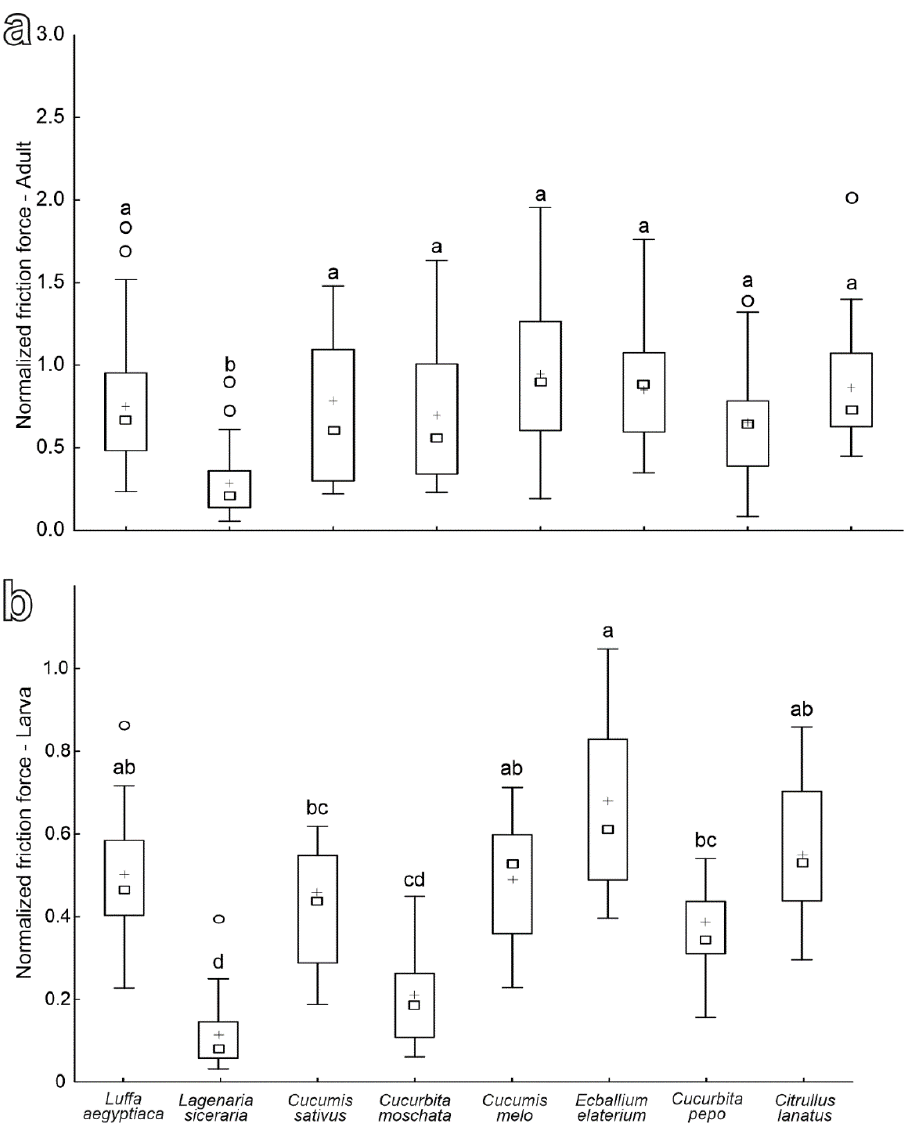
Figure 8. Normalized friction force of females ( a ) and larvae ( b ) of Chnootriba elaterii on the abaxial leaf side of different Cucurbitaceae species. Boxplots show the interquartile range and the medians, whiskers indicate 1.5 × interquartile range, “°” show the outliers and “+“ show the means. Boxplots with different letters are significantly different at p < 0.05 (Tukey unequal N HSD post hoc test, one-way